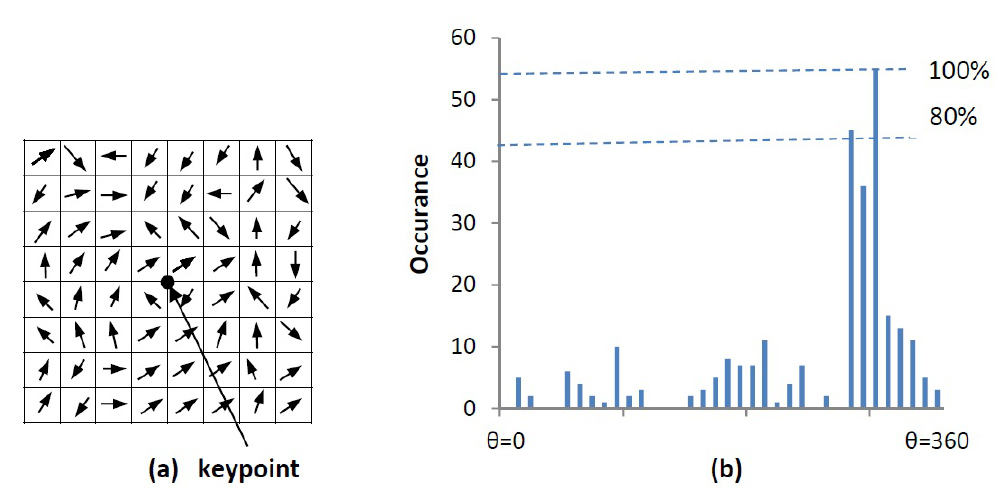
Figure 7. Orientation calculation: ( a ) gradient orientations of sample points within a region around the keypoint ( b ) orientation histogram.